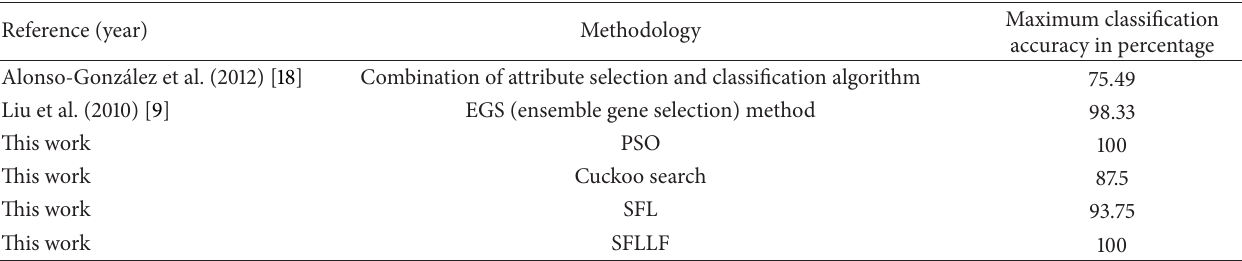
Table 4: Comparison of classification accuracy with other methods for CNS.